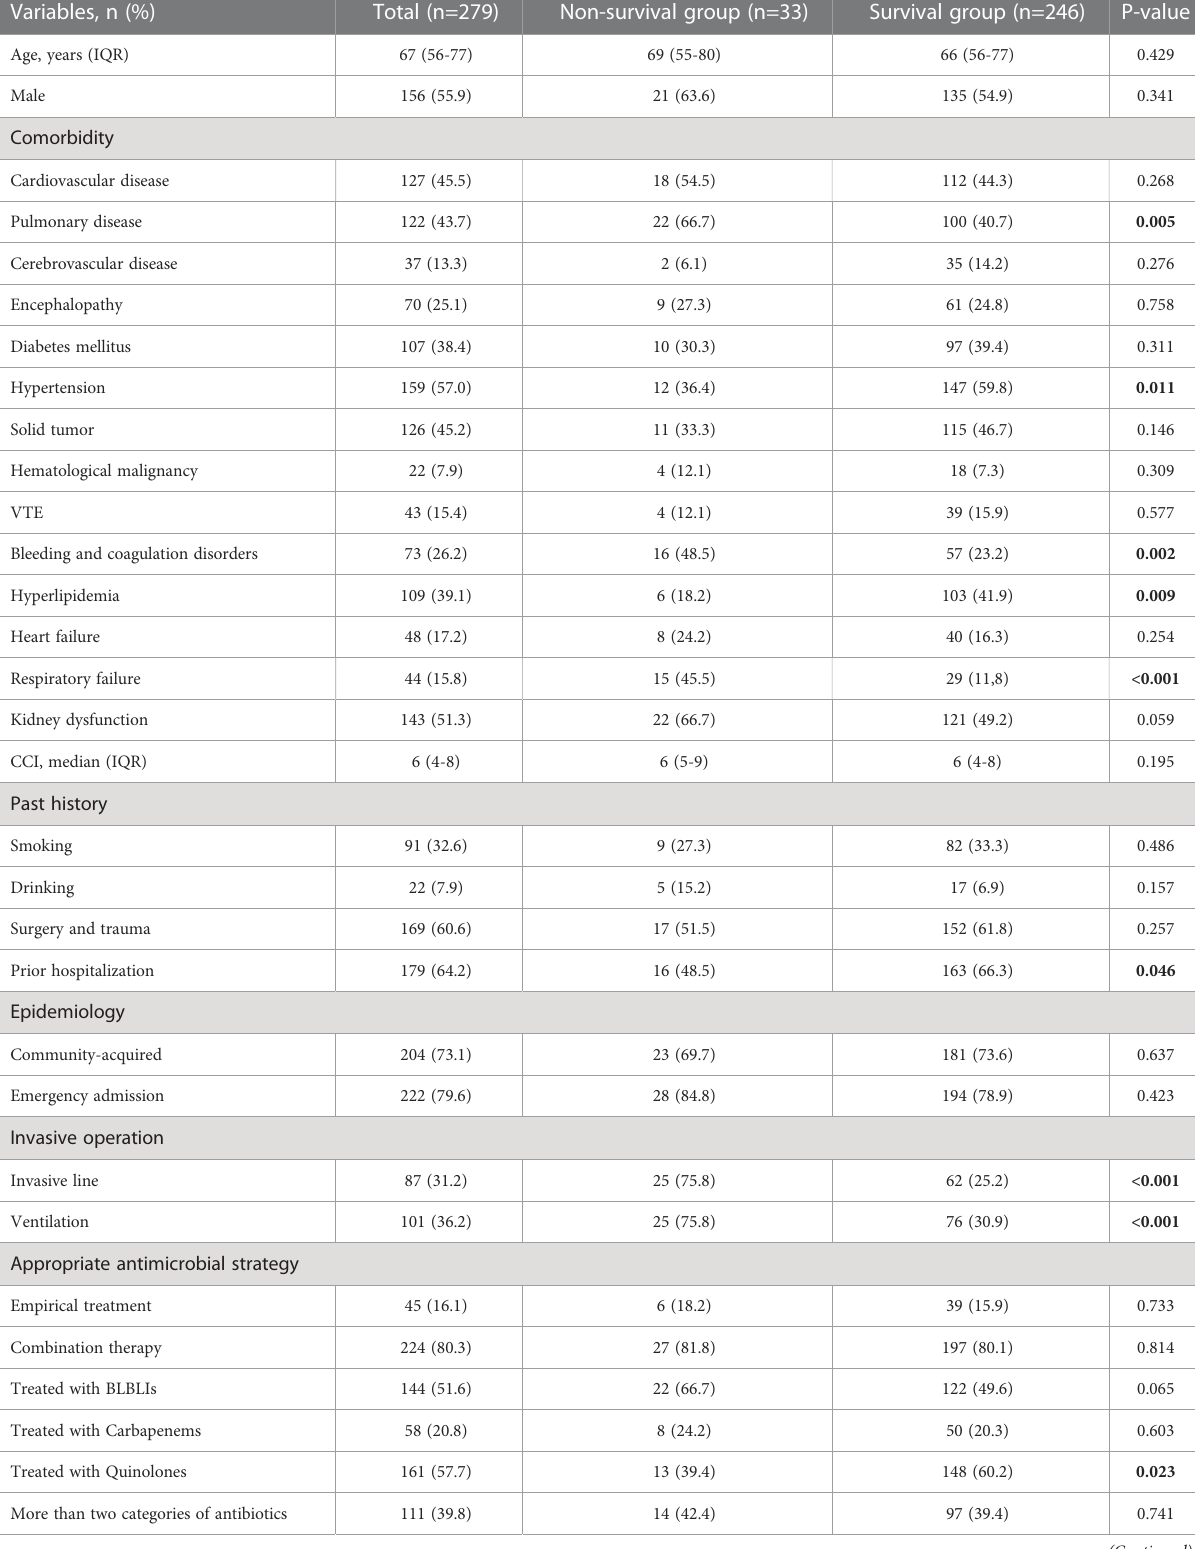
TABLE 1 The demographic and clinical characteristics in non-survival and survival groups of 279 patients with